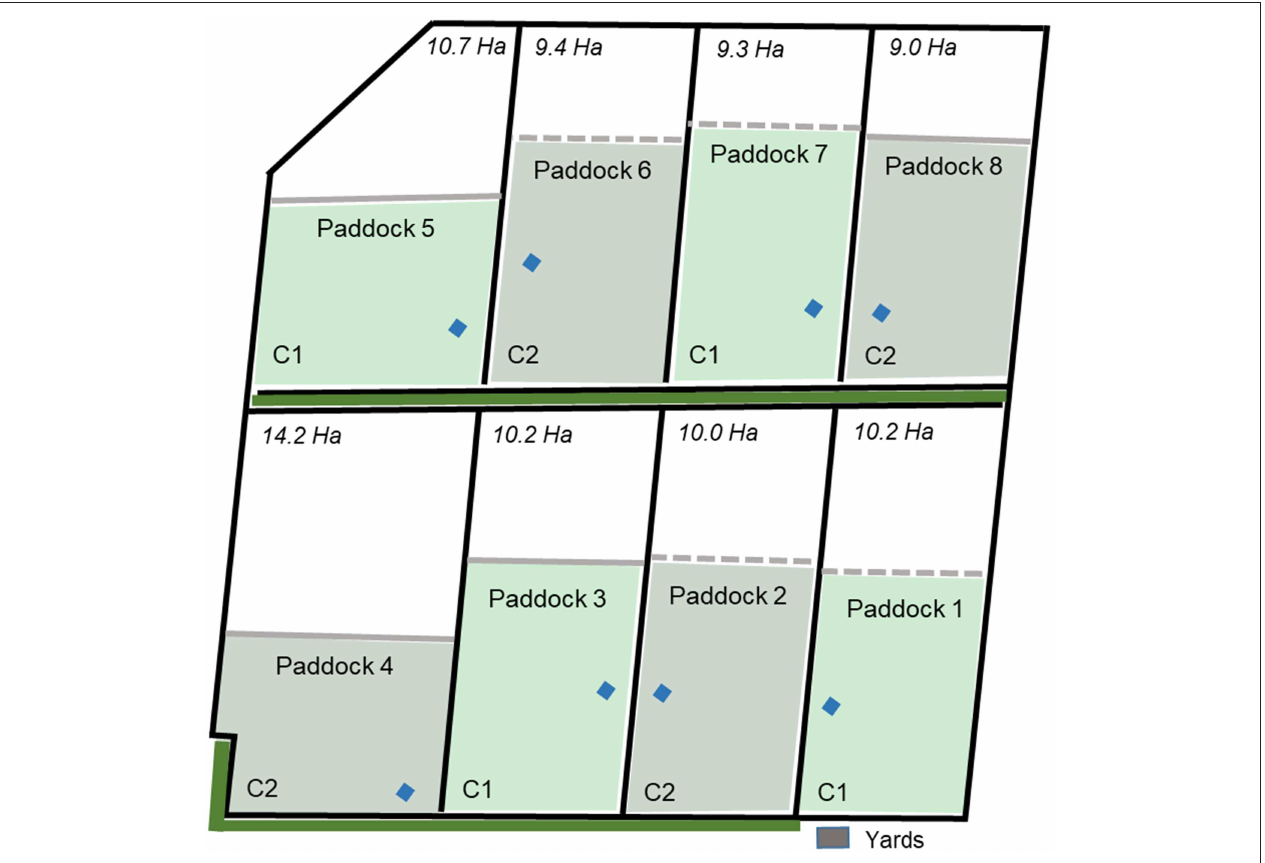
FIGURE 1 | The numbered experimental paddocks showing total paddock size (hectares), the placement of electric tape fences (solid line) or virtual fences (dashed line), the assigned cohort (C1, C2), location of the yards, water points (blue diamonds), and tree line (solid green line) outside the paddock physical fences. Each fenced inclusion zone was 6 ha in size.